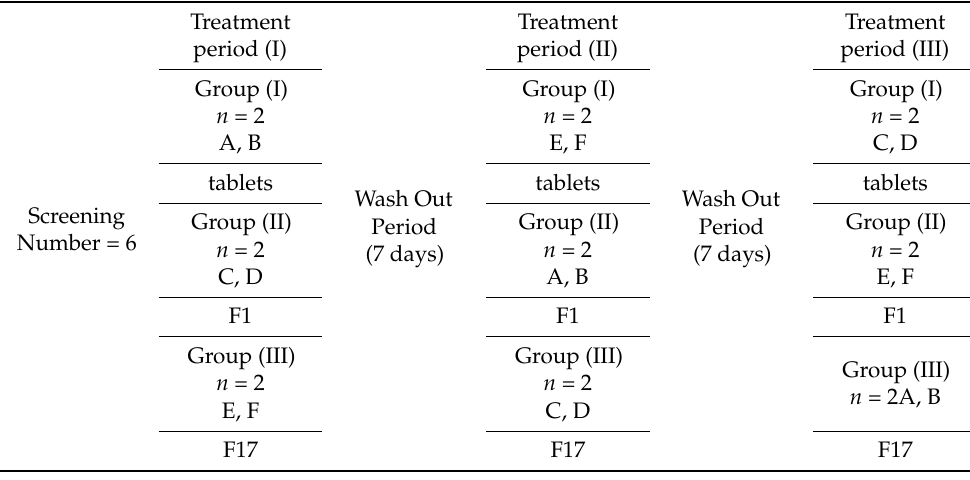
Table 1. A schematic presentation and plan description for the in vivo cross-over study